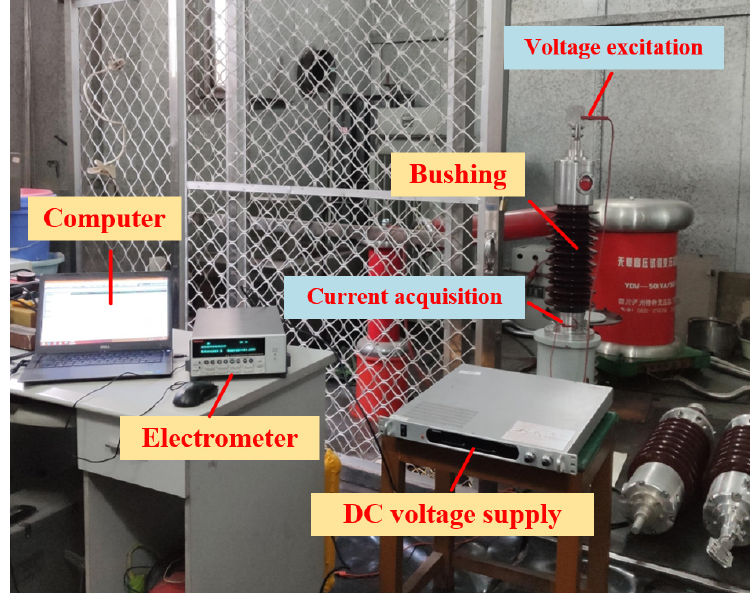
Figure 3. ( b ) Physical diagram.